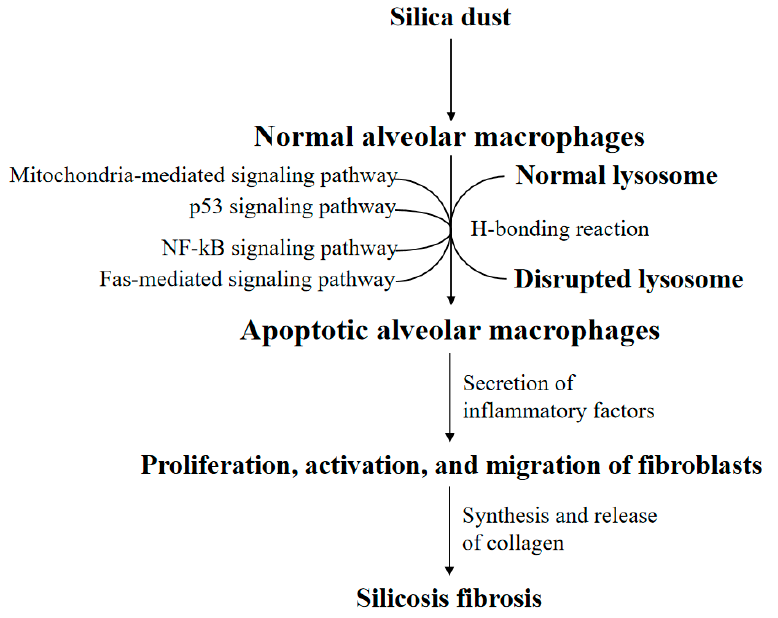
Figure 1. The general silicosis pathological mechanism. The attack of silica dust triggers the phagocytosis of alveolar macrophages (AMs). However, the lysosomal membrane of AM will be disrupted by the H-bonding reaction, causing AM apoptosis. Notably, AM apoptosis may be regulated by the mitochondria apoptotic pathway, Fas apoptotic pathway, nuclear factor kappa-B (NF- κ B) apop- totic pathway, and p53 apoptotic pathway. Apoptotic AM secrets a series of inflammatory factors. Eventually, the proliferation, activation, and migration of fibroblasts synthesize and release collagen, resulting in silicosis